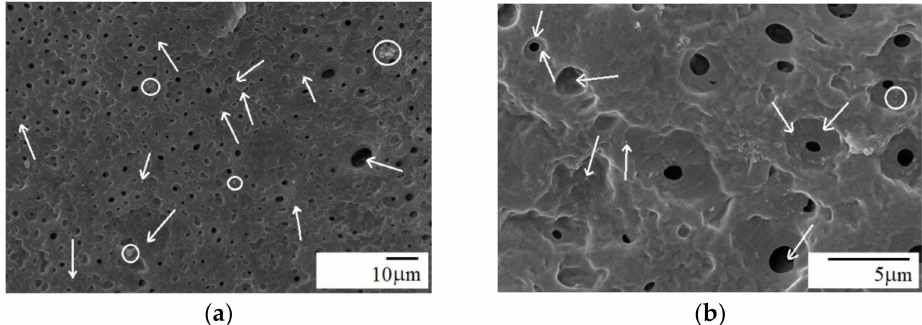
Figure 6. Nitric-acid-etched SEM micrographs of PPO/PA11/SiO 2 80/20/5 composite: ( a ) low magnification, ( b ) high magnification; arrows—silica particles, circles—silica agglomerates.